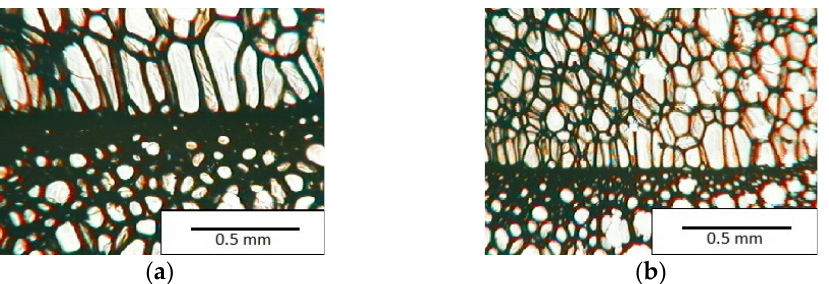
Figure 2. The border between two layers of foamed materials in the bio-based ( a ) and commercial systems ( b ). Table 2. Structural parameters of PUR bio-foams.